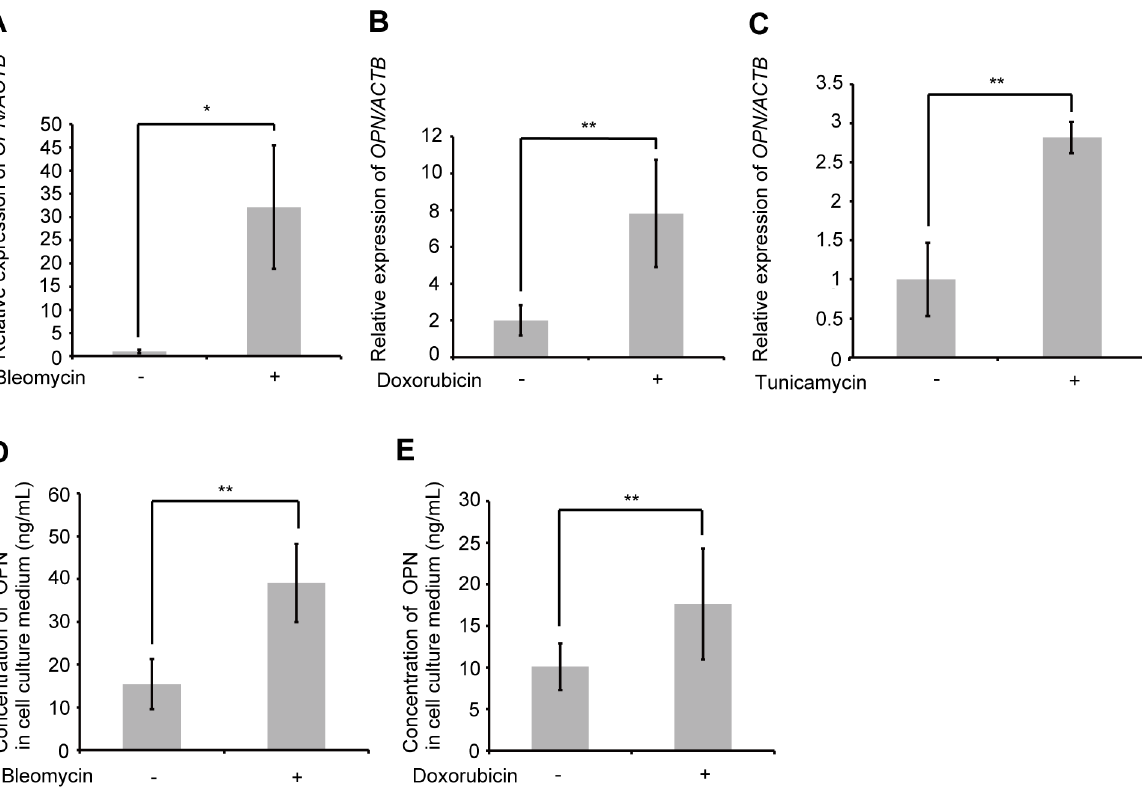
Figure 8. Effect of bleomycin, doxorubicin or tunicamycin on OPN expression in human pulmonary alveolar epithelial cells. (A) HPAEpiC were exposed to 1 m g/mL bleomycin for 48 h. OPN mRNA was assessed by qRT-PCR. (B) HPAEpiC were exposed to 50 nM doxorubicin for 48 h. OPN mRNA was assessed by qRT-PCR. (C) HPAEpiC were exposed to 0.025 m g/mL tunicamycin for 48 h. OPN mRNA was assessed by qRT-PCR. (D) HPAEpiC were exposed to 1 m g/mL bleomycin for 48 h. OPN concentrations in cell culture media were determined by ELISA. (E) HPAEpiC were exposed to 50 nM doxorubicin for 48 h. OPN concentrations in cell culture media were determined by ELISA. Data are presented as mean 6 S.E. *, P , 0.05; **, P , 0.01.